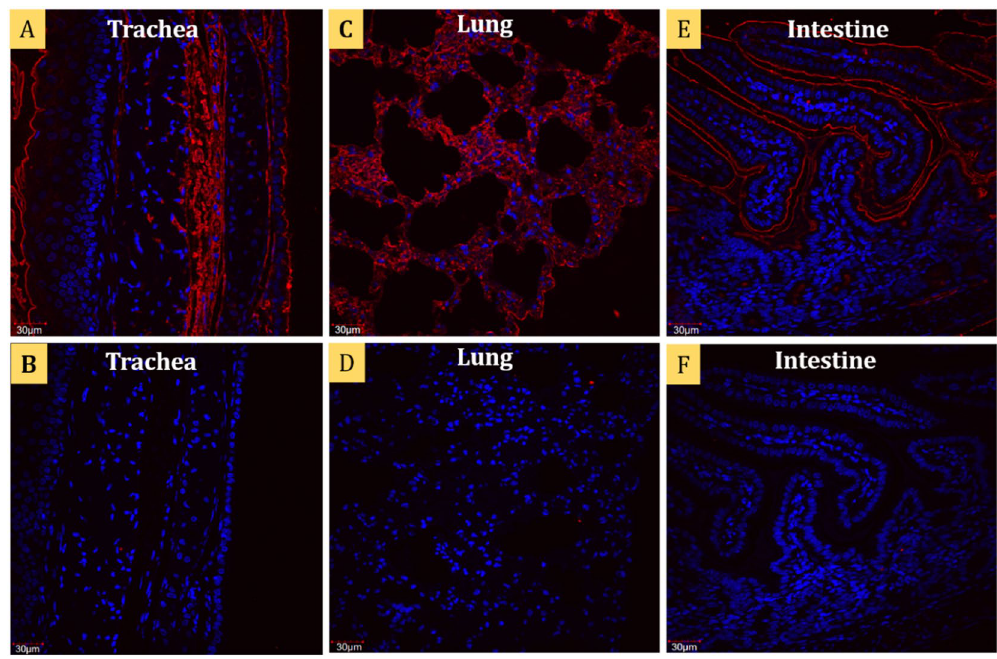
Figure 3. Widespread binding of avian H5N2 virus to LBB tissues. The confocal images show extensive binding of avian H5N2 virus (A/H5N2/chicken/Pennsylvania/7659/1985) to little brown bat (LBB) ( A ) trachea, ( C ), lung and ( E ) intestine. The virus binding pattern reflects the relative abundance of the SA α 2,3-Gal receptors in the trachea, lung and intestine of the little brown bat. The respiratory epithelial cells of trachea and luminal mucosal cells of the intestine show preferential binding to the influenza virus. The lung demonstrates partial virus binding as shown by Cy-5 labeled secondary antibody. ( B , D and F ) Mock treated trachea, lung and intestine